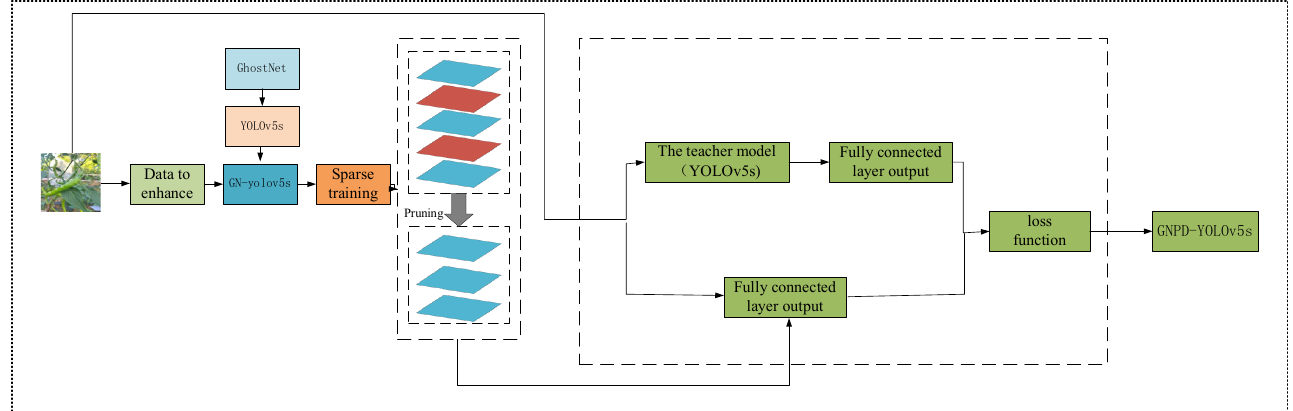
Figure 1. GN - YOLOv5s network architecture.